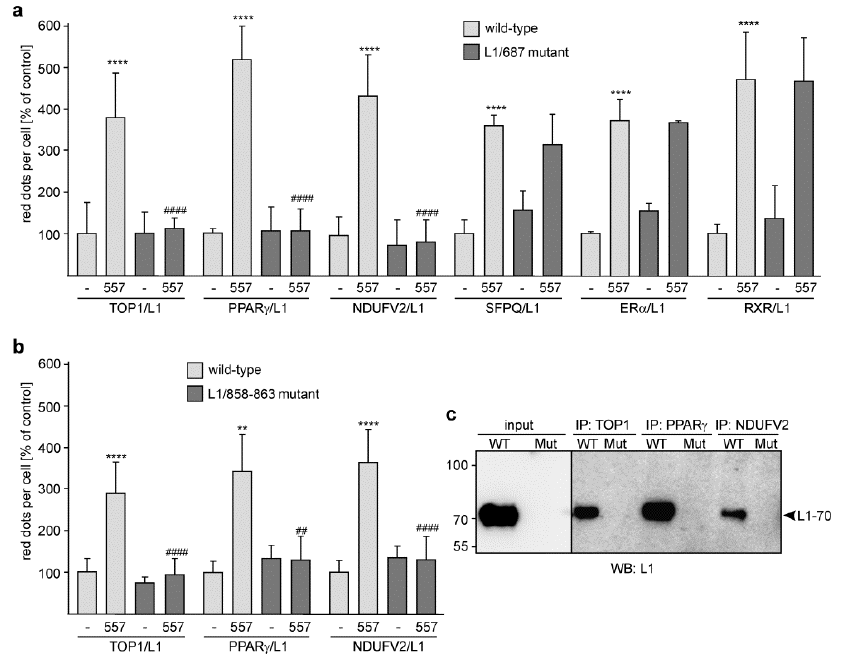
Figure 4. No enhanced interaction of L1 with TOP1, PPAR γ and NDUFV2 in stimulated cortical neurons from L1-70-lacking mutant mice. Cultured cortical neurons from L1/687 ( a ) and L1/858–863 ( b ) mutant mice and their wild-type littermates ( a , b ) were treated without (-) or with L1 antibody 557 (557) and then subjected to proximity ligation assay with L1 antibody and TOP1, PPAR γ or NDUFV2 antibodies. ( a ) For control, the L1 antibody and an antibody against SFPQ, ER α or RXR were used for proximity ligation. ( a , b ) Mean values + SD are shown for the average numbers of L1/TOP1-, L1/NDUFV2-, L1/PPAR γ -, L1/SFPQ-, L1/ER α -, and L1/RXR-positive dots per cell rela- tive to control (values of unstimulated wild-type neurons set to 100%) (** p < 0.01, **** p < 0.001 relative to non-stimulated wild-type neurons, ## p < 0.01, #### p < 0.001 relative to stimulated wild-type neurons; one-way ANOVA with Dunn’s multiple comparison test). ( c ) Non-nuclear brain fractions from wild-type (WT) and L1/858–863 mutant (Mut) mice were subjected to im- munoprecipitation (IP) with immobilized mouse antibodies against TOP1, PPAR γ and NDUFV2. Non-nuclear fractions (input) and immunoprecipitates were subjected to Western blot (WB) anal- ysis with L1 antibody C-2. The arrowhead indicates L1-70. To gain more evidence for L1-70’s association with TOP1, PPAR γ and NDUFV2, immunoprecipitation was performed with immobilized antibodies and a non-nuclear brain fraction of wild-type and L1-70-lacking mutant mice. Western blot analysis indi- cates one L1-immunopositive band of 70 kDa in the TOP1, PPAR γ and NDUFV2 im-